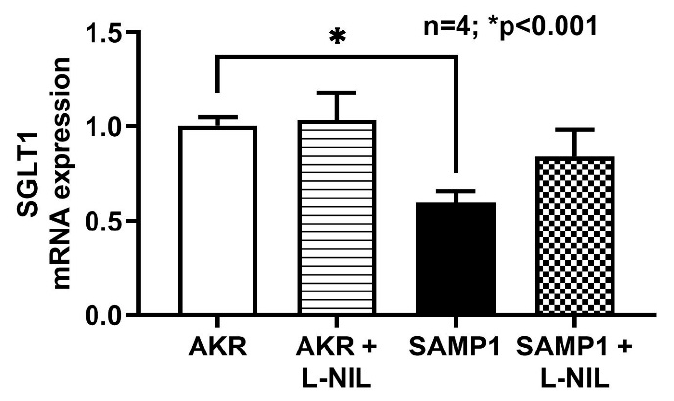
Figure 7. RT-qPCR analysis of SGLT1 mRNA expression. SGLT1 mRNA expression levels were significantly inhibited in SAMP1 mice villus cells compared with control AKR mice. L-NIL treatment reversed the inhibition of SGLT1 mRNA expression levels in SAMP1 mice to normal levels. However, SGLT1 mRNA expression levels remained unchanged between AKR mice untreated and treated with L-NIL.